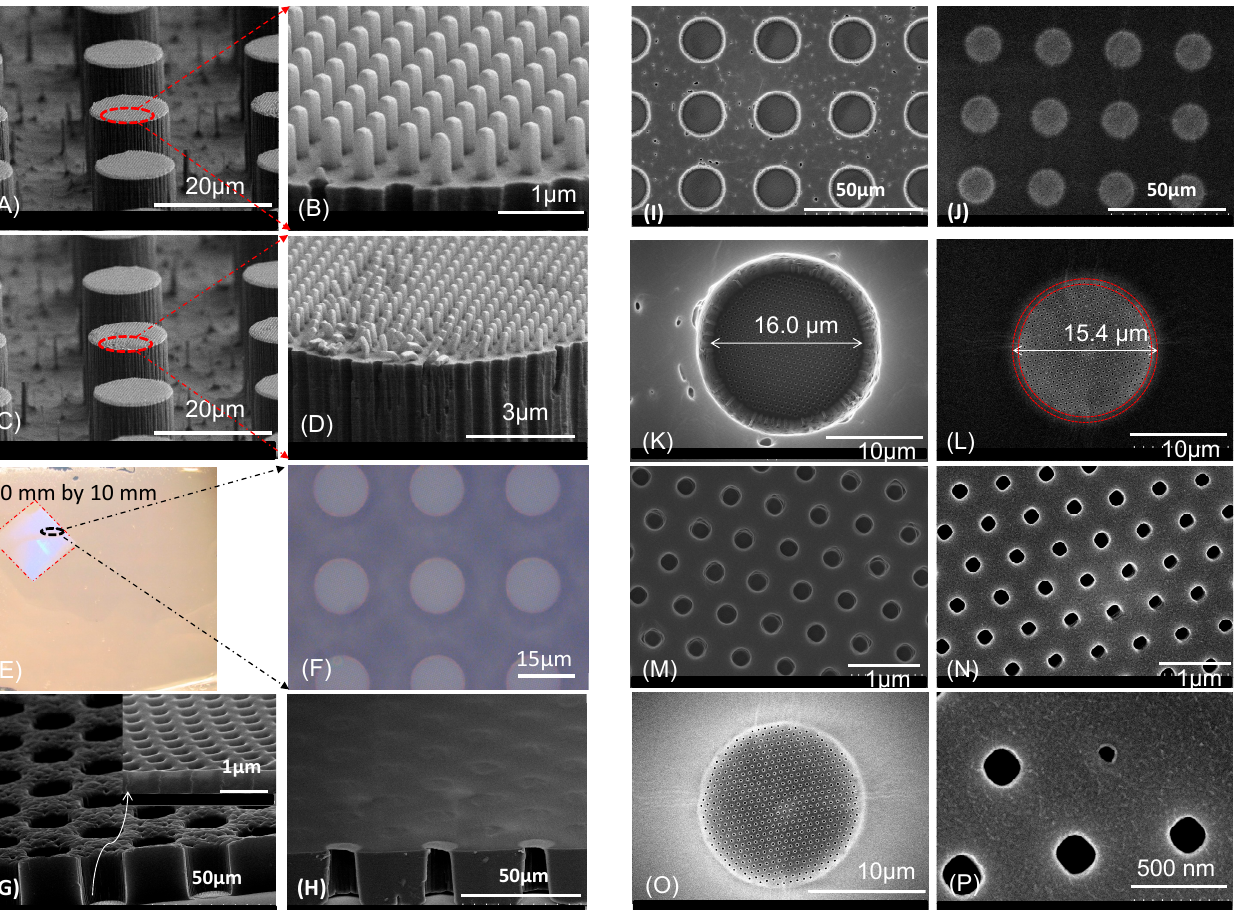
Figure 5. ( A , C ) SEM images of hot-embossed Zeonor 1060R substrates with a combined hierarchical nanopillars and micropillars. Some nanopillars defects, resulting from the demolding process, can be seen. ( B , D ) Close-up SEM images of the pillar tops shown in ( A , C ). ( E ) A piece of CUVR1534 polymer membrane (44 × 44 mm 2 ), the region marked by dashed red lines is the membrane with hierarchical micro- and nano-holes. ( F ) An optical microscope image of the membrane inside the marked region. ( G , H ) SEM images (tilt at 75 ◦ ) of a CUVR1534 membrane with combination of nano-/micro-open-through holes (shown from bottom and top sides, respectively). Insert in ( G ) is the cross-section view of the membrane with nano-holes. ( I , J ) are elevated view SEM images of the membrane from top for both the bottom and top side of the membrane, respectively. ( K – N ) are the SEM images of ( I , J ) at higher magnifications, the diameter of the open through hole at the bottom side is around 250 nm (rounded square), while it is about 200 nm to 210 nm at the top. ( O , P ) are the elevated view SEM images of the membrane at a location where an open-through hole of about 70 nm was observed at the edge of a 15 µ m